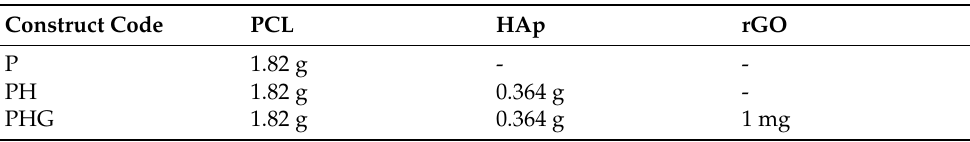
Table 3. Chemical compositions and codes of the patterned constructs for the solvent (10 mL 1,4- dioxane) and non-solvent (200 mL EtOH)